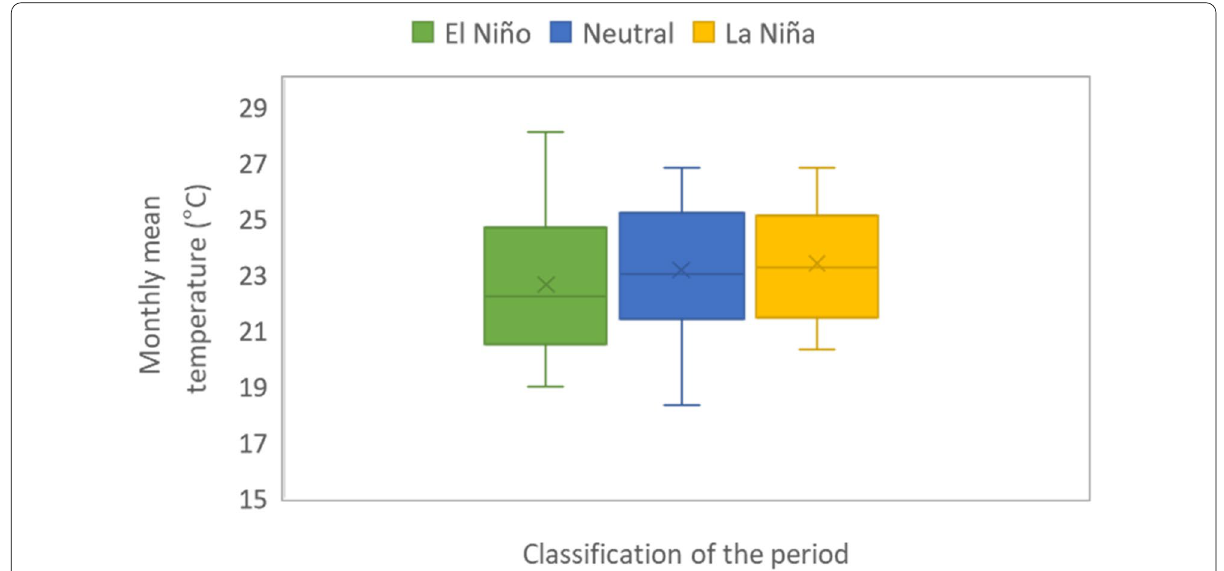
Fig. 5 Distribution of the monthly mean temperature as a function of classification of the period